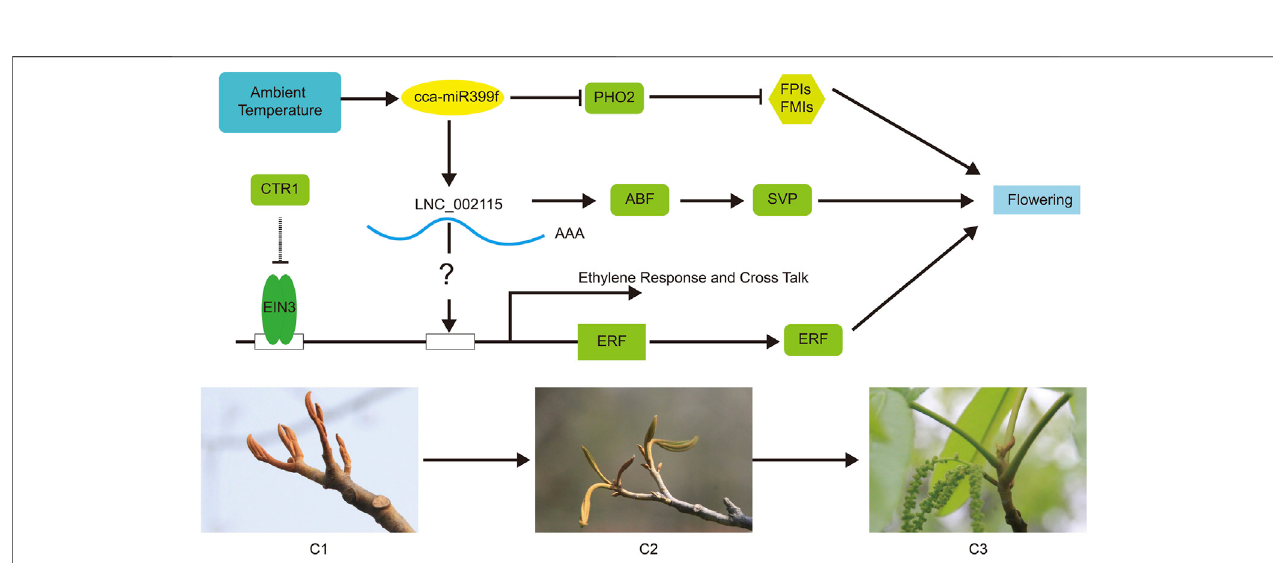
FIGURE 9 | The competing endogenous RNA (ceRNA) regulation hypothetical model of hickory female fl oral bud development during the change of ambient temperature.Thearrowsindicatepositiveregulation,andblunt-endedbarsindicateinhibition.Alinedoesnotnecessarilyrepresentuniqueordirectregulation.Changein ambienttemperaturemayin fl uence fl oweringbyaffectcca-miR399ftosuppresstheexpressionof PHO ,therebyinhibitingtheexpressionof fl oralmeristemidentity(FMI) and fl oral pathway integrator (FPI) genes. Meanwhile, cca-miR399f stimulated the expression of ABF and SVP by promoting the expression of LNC_002115, thereby affecting fl owering. LNC_002115 might also interact with the ERF promoter to activate ERF expression and ultimately affect fl owering. ABF (CCA0670S0070), ABRE-binding factor ; CTR1 (CCA0854S0091) ,Copper transporter 1;EIN3 (CCA0613S0076) , ETHYLENE-INSENSITIVE3; ERF (CCA0510S0116) ,Ethylene-responsive element-binding factor ; PHO2 (CCA1565S0006) , PHOSPHATE2; SVP (CCA1068S0034) , SHORT VEGETATIVE